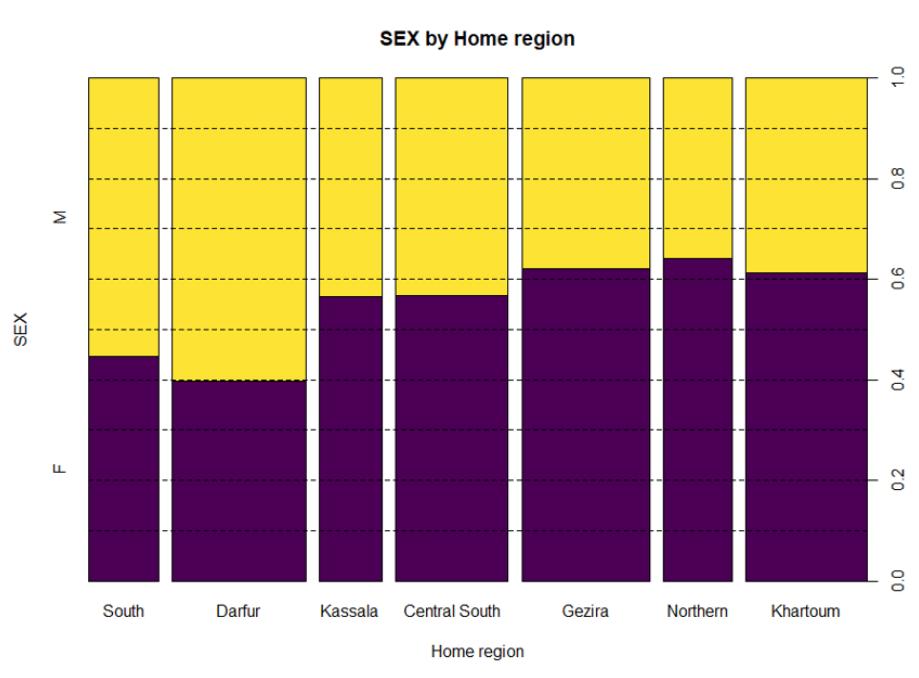
Figure 12. Male/female proportions by home region, incoming bachelor’s students 2016–2017.